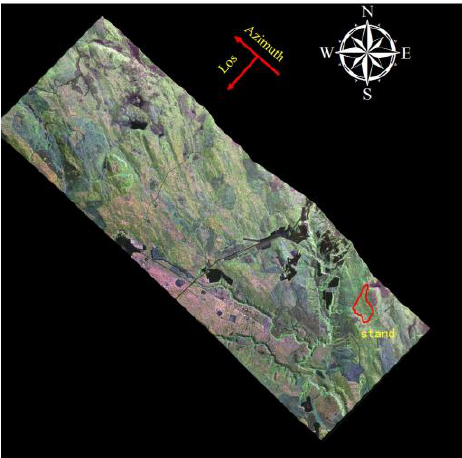
Figure 3. Pauli decomposition RGB image of the test site overlaid by the forest stand vector boundary (red polygon)